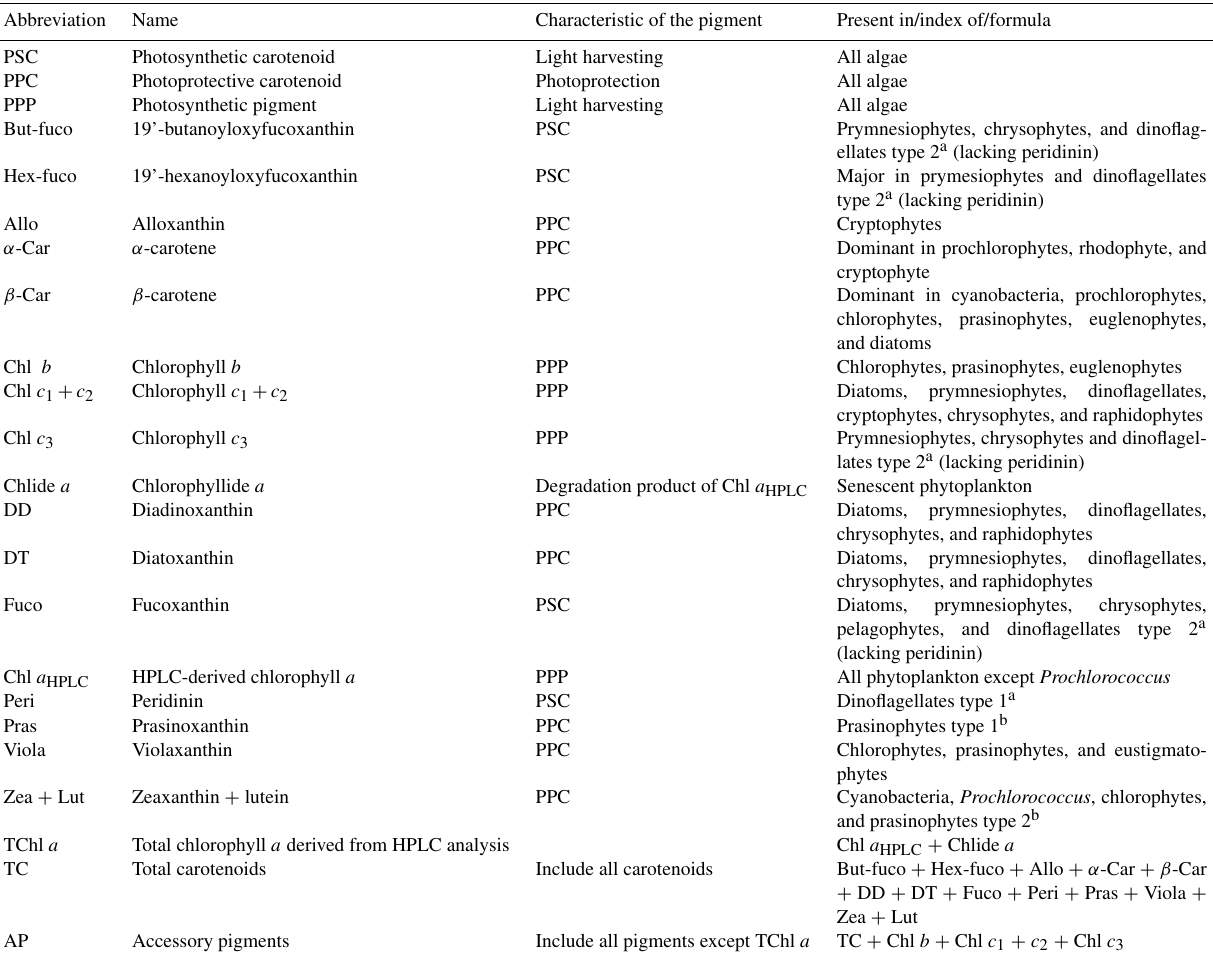
Table 2. List of phytoplankton pigments and their distributions in algae groups; abbreviations and